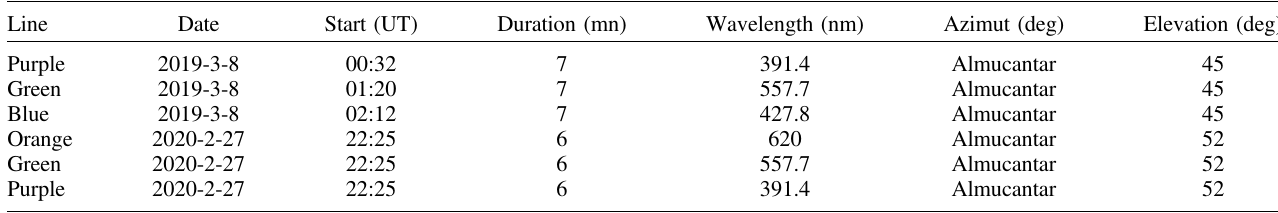
Table 1. List of the observations considered throughout this